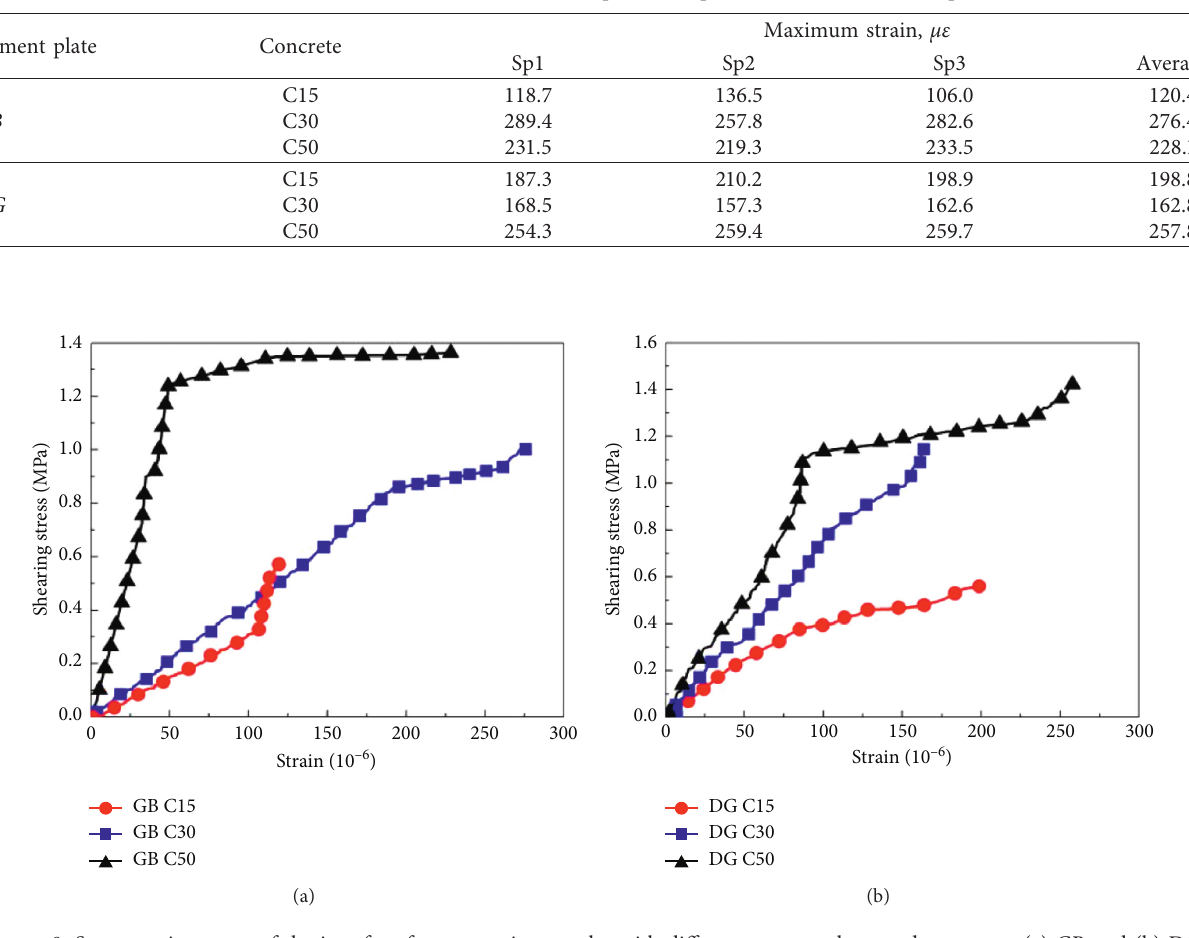
Figure 8: Stress-strain curves of the interface for composite samples with different cement plates and concretes: (a) GB and (b)